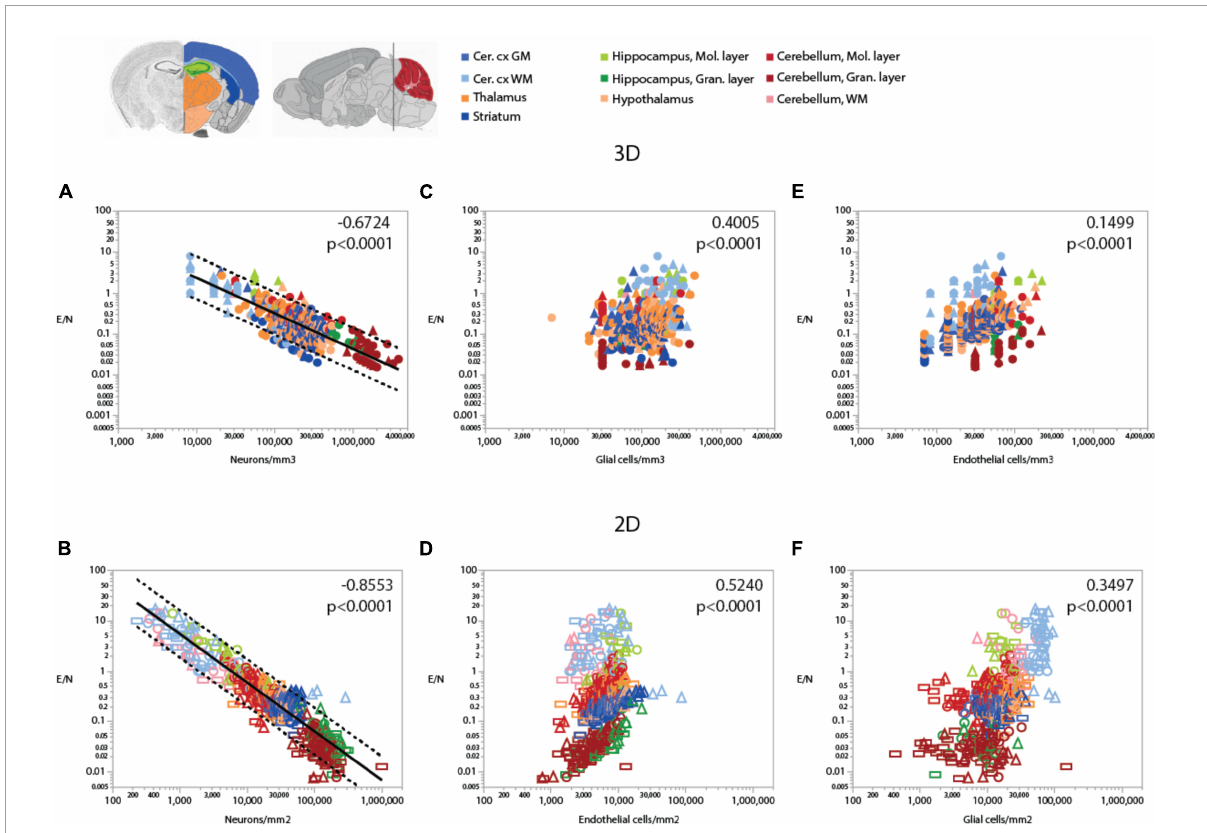
FIGURE7 Ratio of endothelial cells per neuron (E/N) varies widely and uniformly across brain structures and sites depending on local neuronal density, but correlations with glial and endothelial cell densities only apply locally. Spearman correlation coefficients and p -values across all structures and sites are indicated in each graph; correlations and power function exponents for each structure are listed in Table 4 . (A,B) E/N ratios span three orders of magnitude across brain sites and structures and vary as a single power function of local neuronal density whether measured in 3D stacks (A ) or in 2D composite images (B) . (C,D) E/N ratio appears to correlate with local glial cell density across brain structures in both datasets, but closer inspection reveals that the overall correlation results from the combination of locations and does not hold within most structures (see Table 3 ). (E,F) In contrast, E/N ratios are strongly correlated with endothelial cell densities locally within each structure, but different brain structures have non-overlapping E/N ratios with similar endothelial cell densities, indicating that the apparent overall correlation does not result from a universal correlation, unlike that seen for the strong and universal correlation between E/N and neuronal density (A,B) . All graphs are shown with similar X and Y scales for